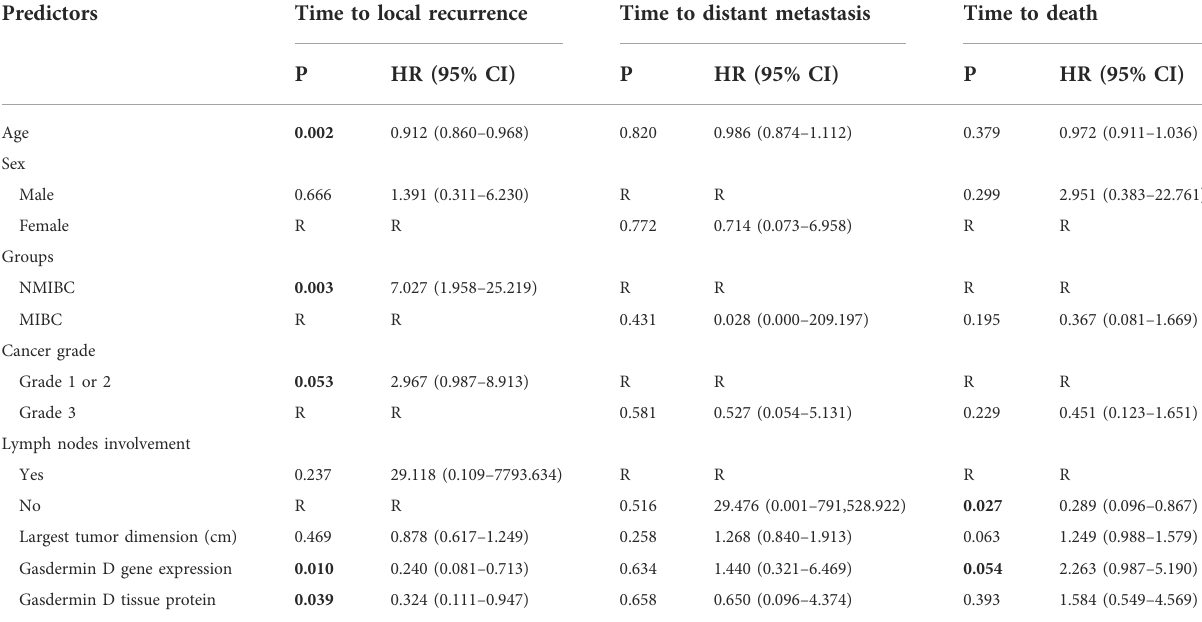
TABLE 10 Individual predictors of bladder cancer local recurrence, distant metastasis and death: